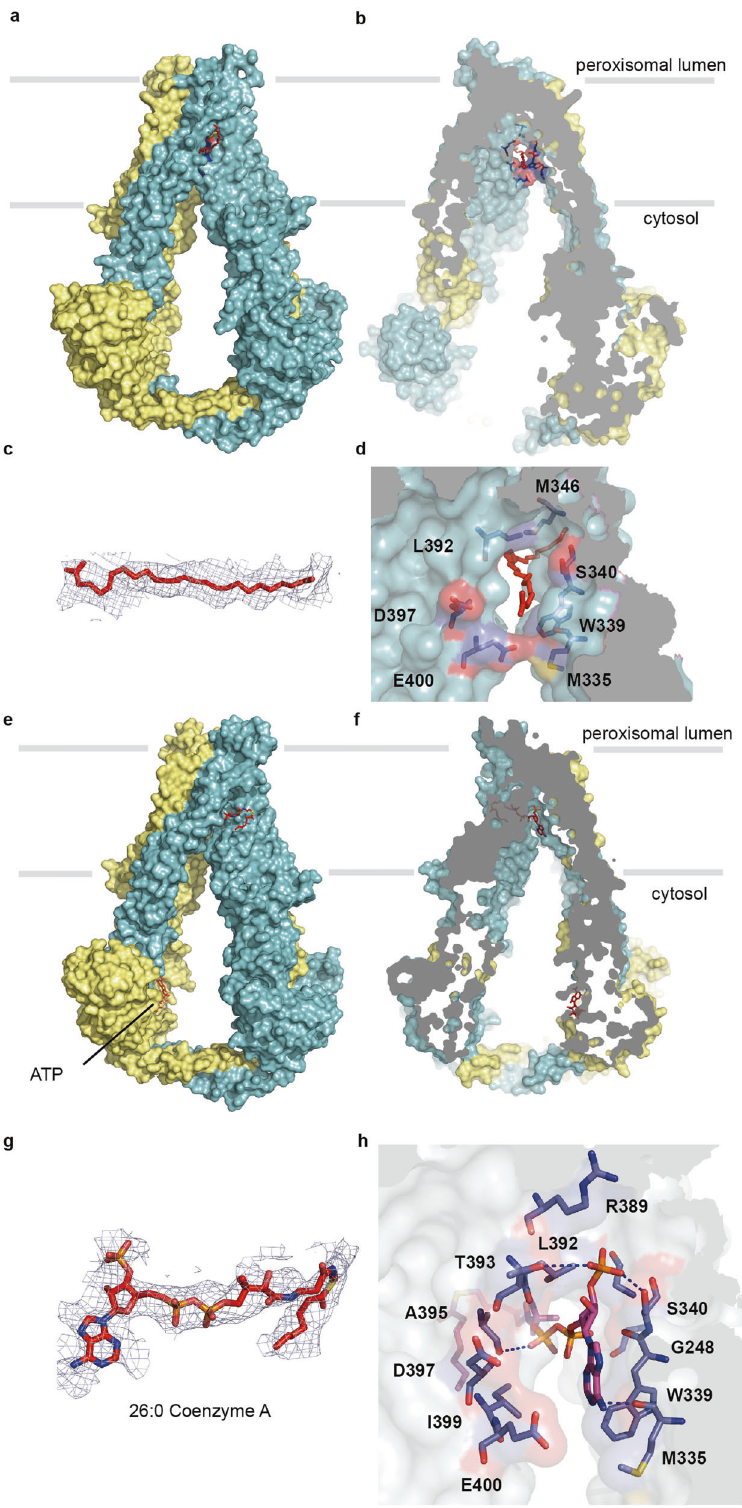
Fig. 3 Inward-facing structure of ABCD1 with a cytosolic vestibule that houses the substrate-binding site. a , b Surface representation of ABCD1 showing that C26:0 binds to a vestibule that penetrates half-way into the lipid bilayer. c , d Electron density map of C26:0 substrate and zoomed-in view of the substrate in the same orientation as b , respectively. e , f Overall and slice views of ABCD1-E630Q in complex with C26:0- CoA as surface representation, respectively. g , h EM density of parts of C26:0-CoA and zoomed-in view of the CoA binding site, respectively. The EM density maps in c and g are displayed at the same sigma level (5 σ )